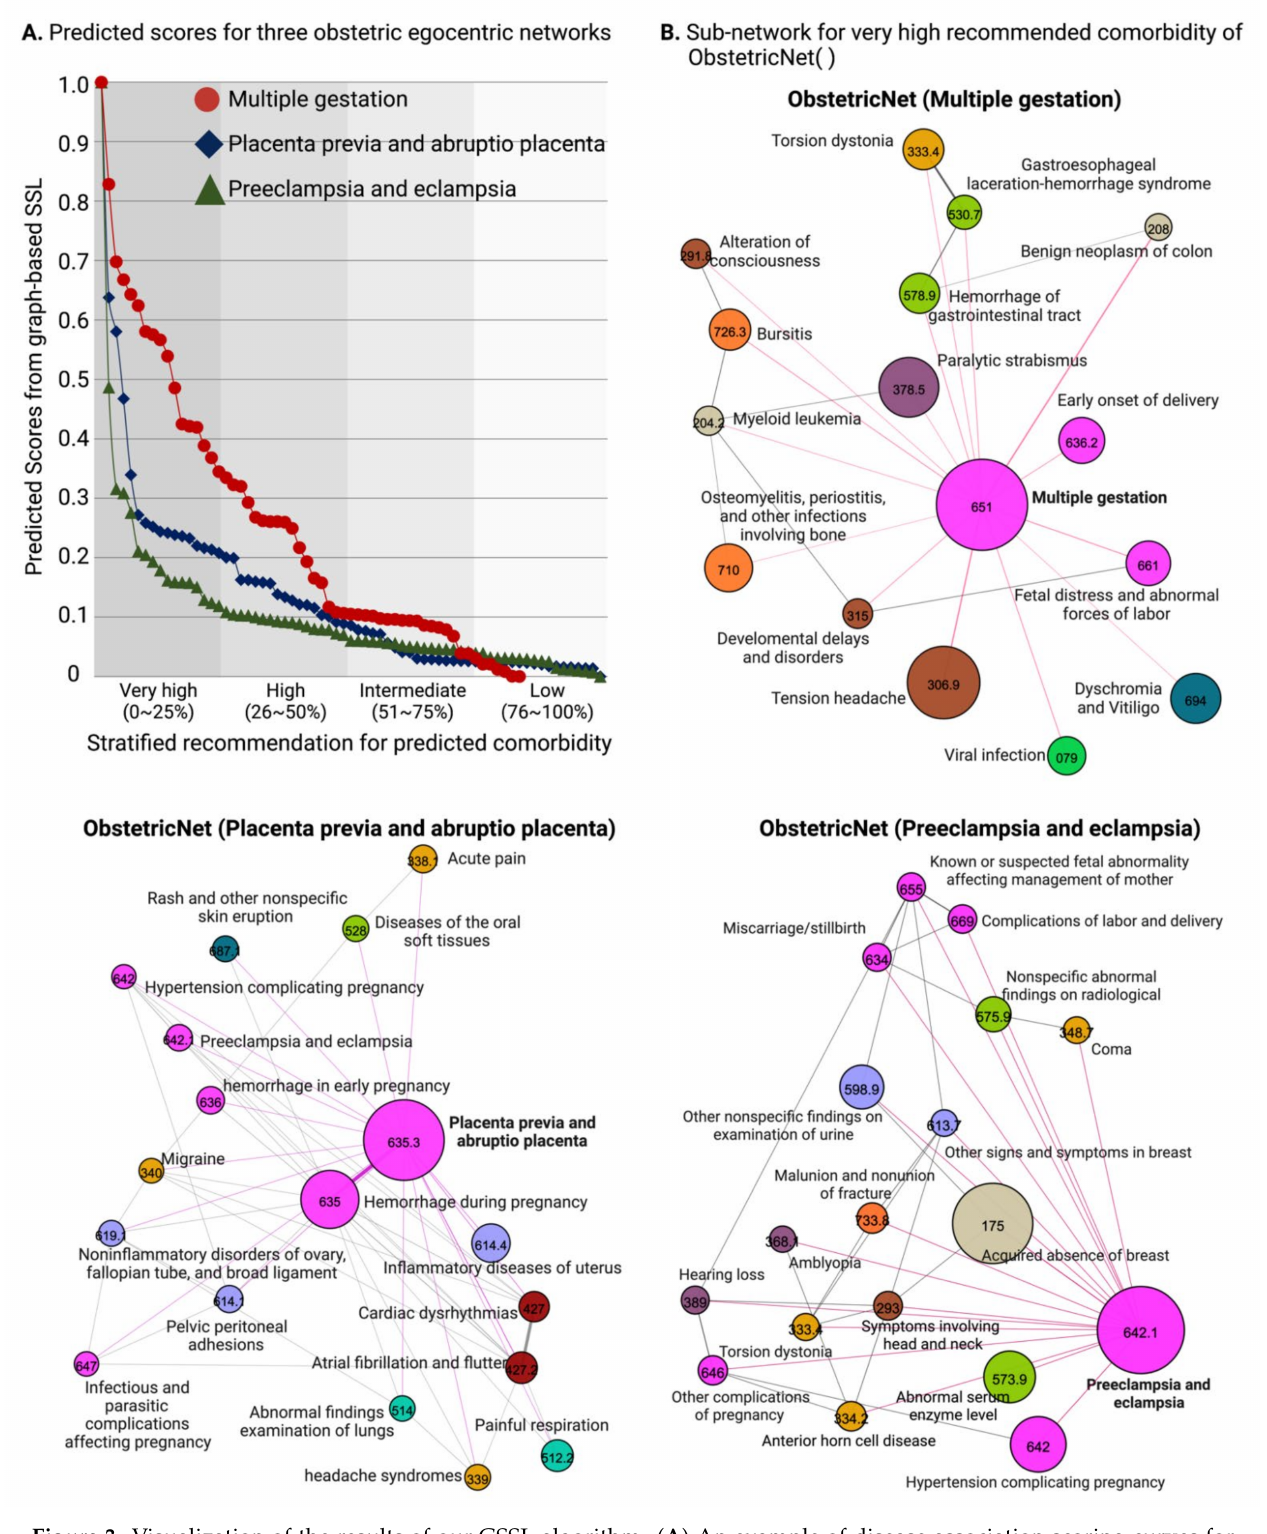
Figure 3. Visualization of the results of our GSSL algorithm. ( A ) An example of disease association scoring curves for placenta previa (PheCode 635.3), multiple gestation (PheCode 651), and preeclampsia (PheCode 642.1). ( B ) Subnetworks depicting phenotypes with scores in the top 25th percentile for each of the three sample